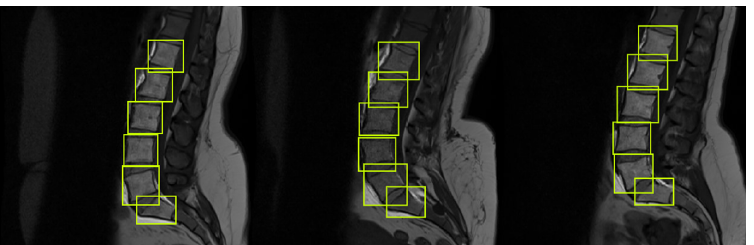
Figure 5. Images are labeled in mid-sagittal view. Each image has the label file of the same name which is generated after labeling the image, and it contains the class, coordinates, and height and width of the objects that are lumbar vertebrae and sacrum bone in this